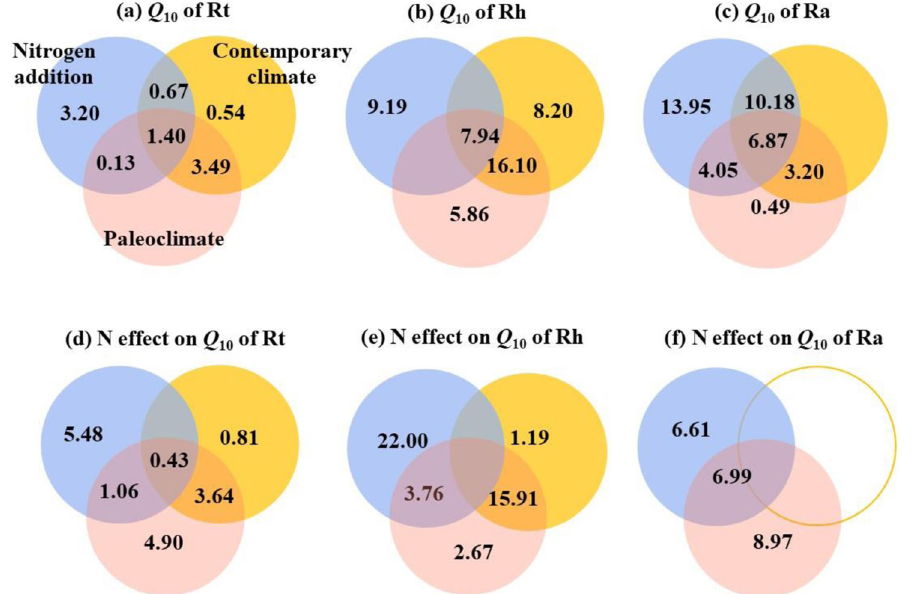
Fig. 3 Environmental and anthropogenic controls on the temperature sensitivity of soil respiration and their responses to nitrogen enrichment. Variance partitioning for three categories: nitrogen addition traits, contemporary climate, and paleoclimate in explaining variations in the temperature sensitivity of total soil respiration ( a ), heterotrophic respiration ( b ), and autotrophic respiration ( c ) and their responses to nitrogen enrichment ( d, e, f ), respectively. The blue, yellow, and pink colors represent, respectively, nitrogen addition traits, contemporary climate, and paleoclimate. Values < 0 are not shown. The dotted circle indicates that no predictor was found to be signi fi cant in this modeling. See p values associated with each ecological predictor in Supp. Tables 2 – 7.